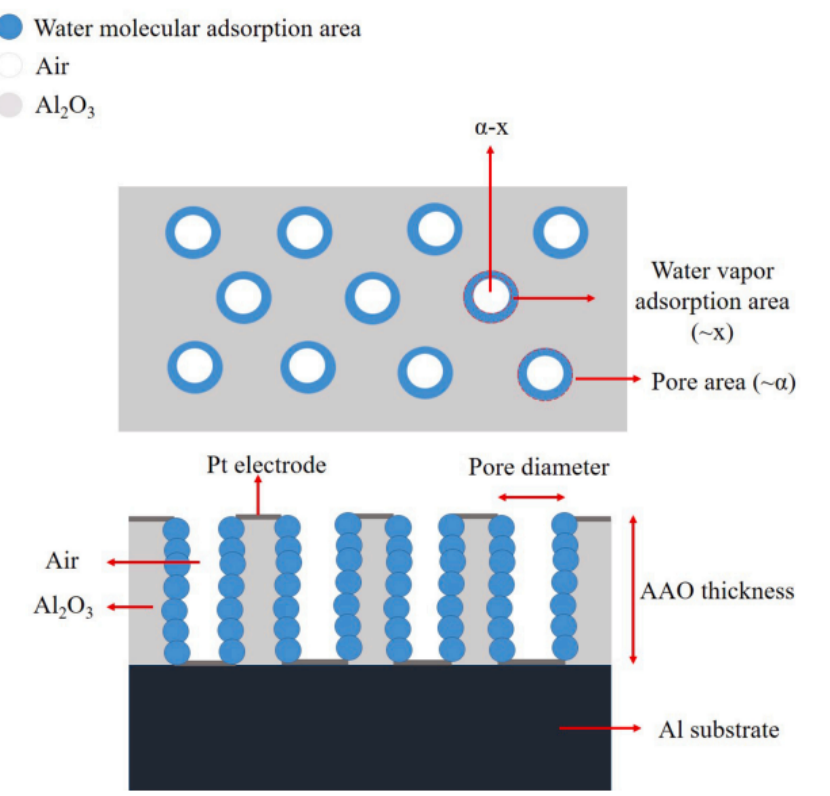
Figure 15. The schematic diagram of AAO capacitor. The water-molecules adsorption ratio is assumed to be x, the porosity is α , and the air area ratio is α –x.